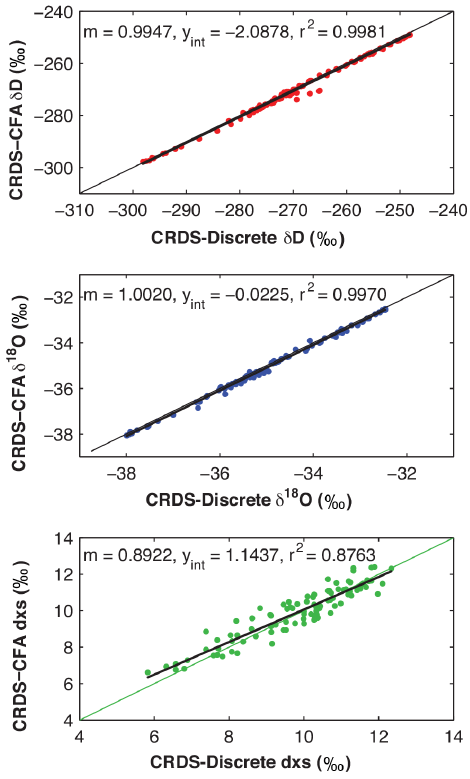
Figure 8. Scatterplots of GTI comparisons of CRDS-CFA vs. CRDS-discrete data. Seven GTI sticks were analyzed on the CRDS- CFA system, down-sampled to 1cm, and averaged. The discrete data were sampled at 1cm and analyzed on a separate Picarro L- 2130i using the average of three injections. The black line is the best-fit linear regression. The 1 σ errors for the slope and intercept of the δ D regression are 0.0035 and 0.9346, respectively. For the δ 18 O regression, the errors are 0.0045 and 0.1555, respectively. For the dxs regression, the errors are 0.0315 and 0.3116, respectively.